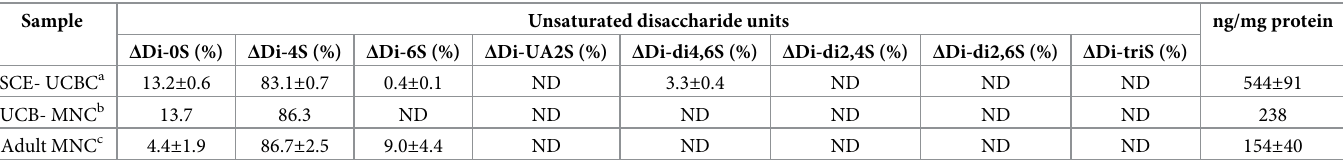
a stem-cell-enriched umbilical cord blood cells (n = 3), b mononuclear cells derived from rat umbilical cord blood (collected from 70 pups), c mononuclear cells derived from peripheral blood of adult rat (n = 3).